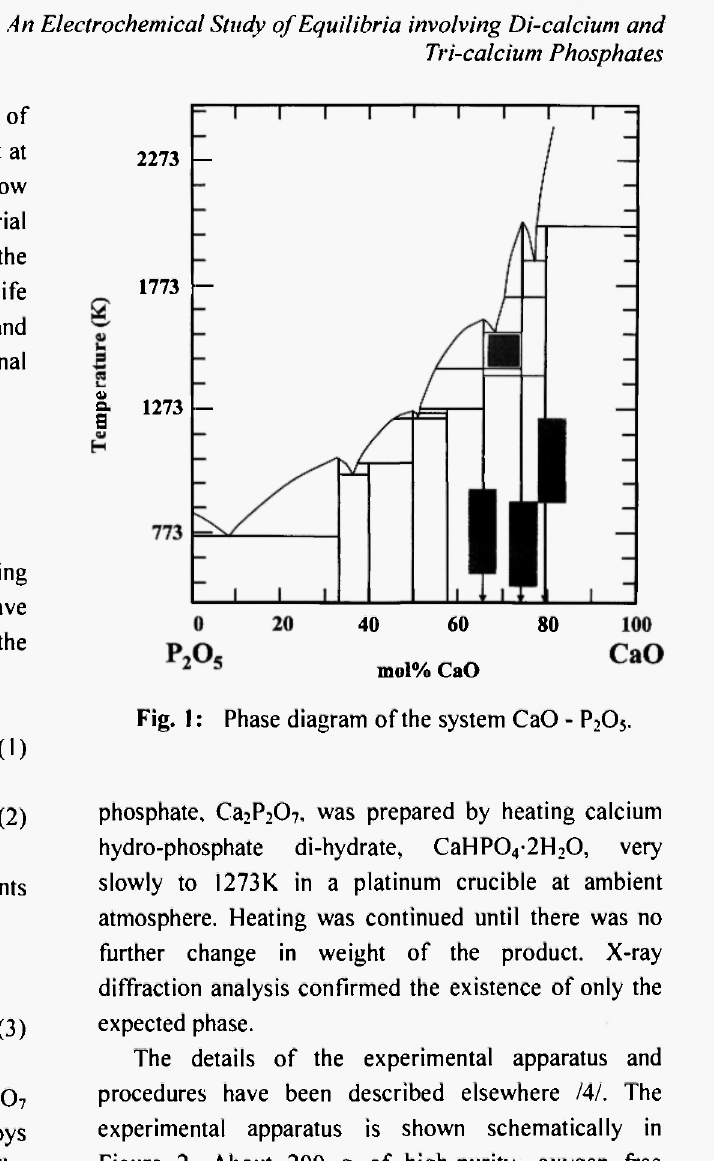
Figure 2. About 200 g of high-purity, oxygen free copper and copper phosphide, Cu 3 P, were melted in a molybdenum crucible of 38mm o.d., 33mm i.d. and